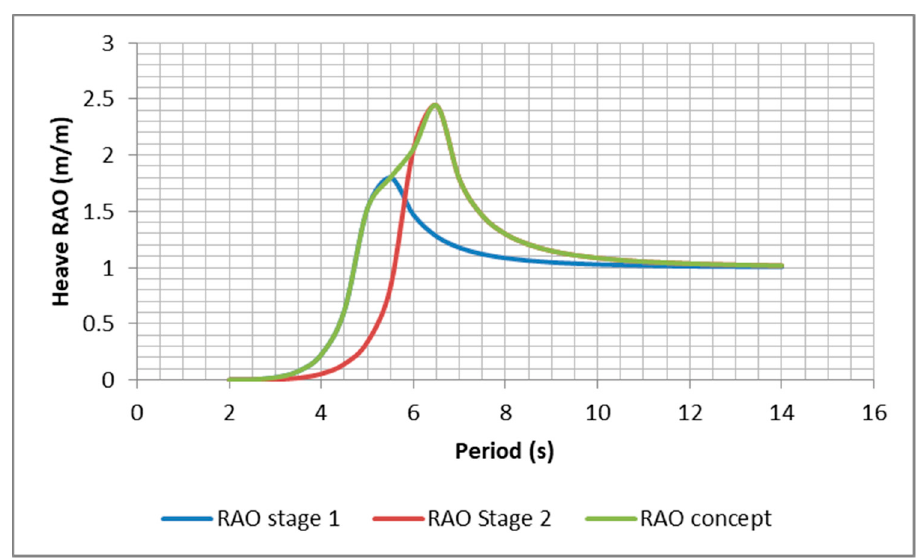
Figure 5. RAO curves of the WEC at Stage 1 (resonant period as 5.5 s), Stage 2 (resonant period as 6.5 s), and the proposed self-adjustable WEC with critical wave period as 6.0 s.